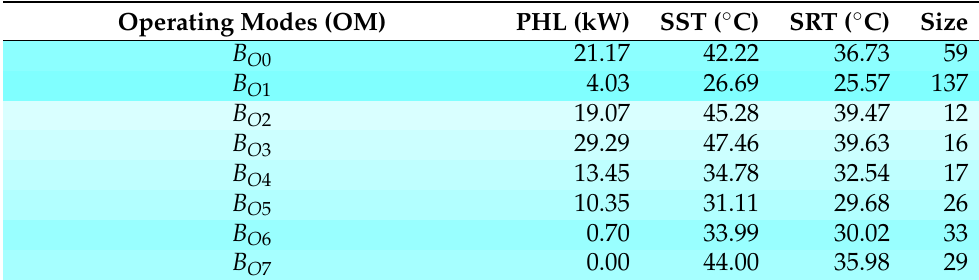
Table 8. Operating modes identified after receiving chunk 3.